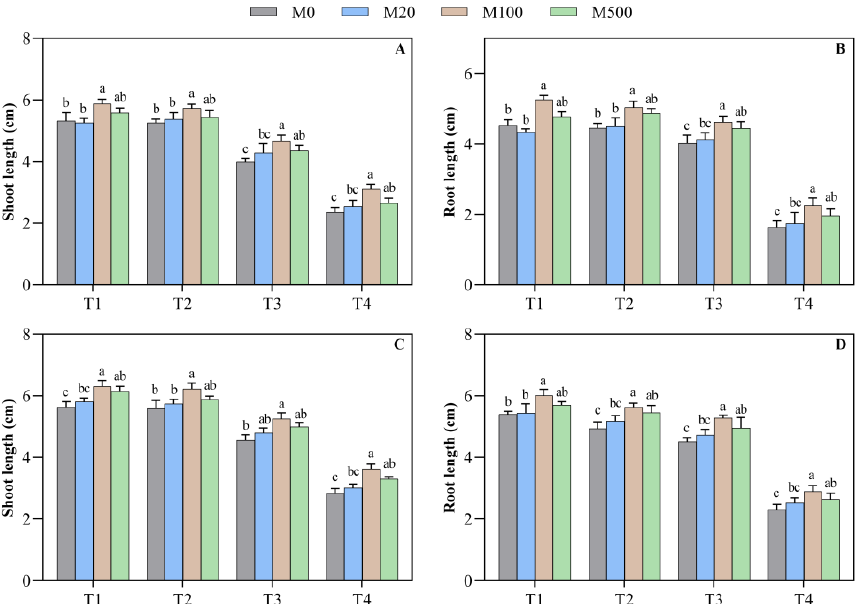
Figure 2. Effects of exogenous melatonin on morphological characteristics of rice seed shoots and roots under high temperature stress. Means ± SEs with different letters in each parameter indicate significant statistical differences ( p < 0.05). ( A ) Shoot length (7 d); ( B ) root length (7 d); ( C ) shoot length (9 d); and ( D ) root length (9 d).